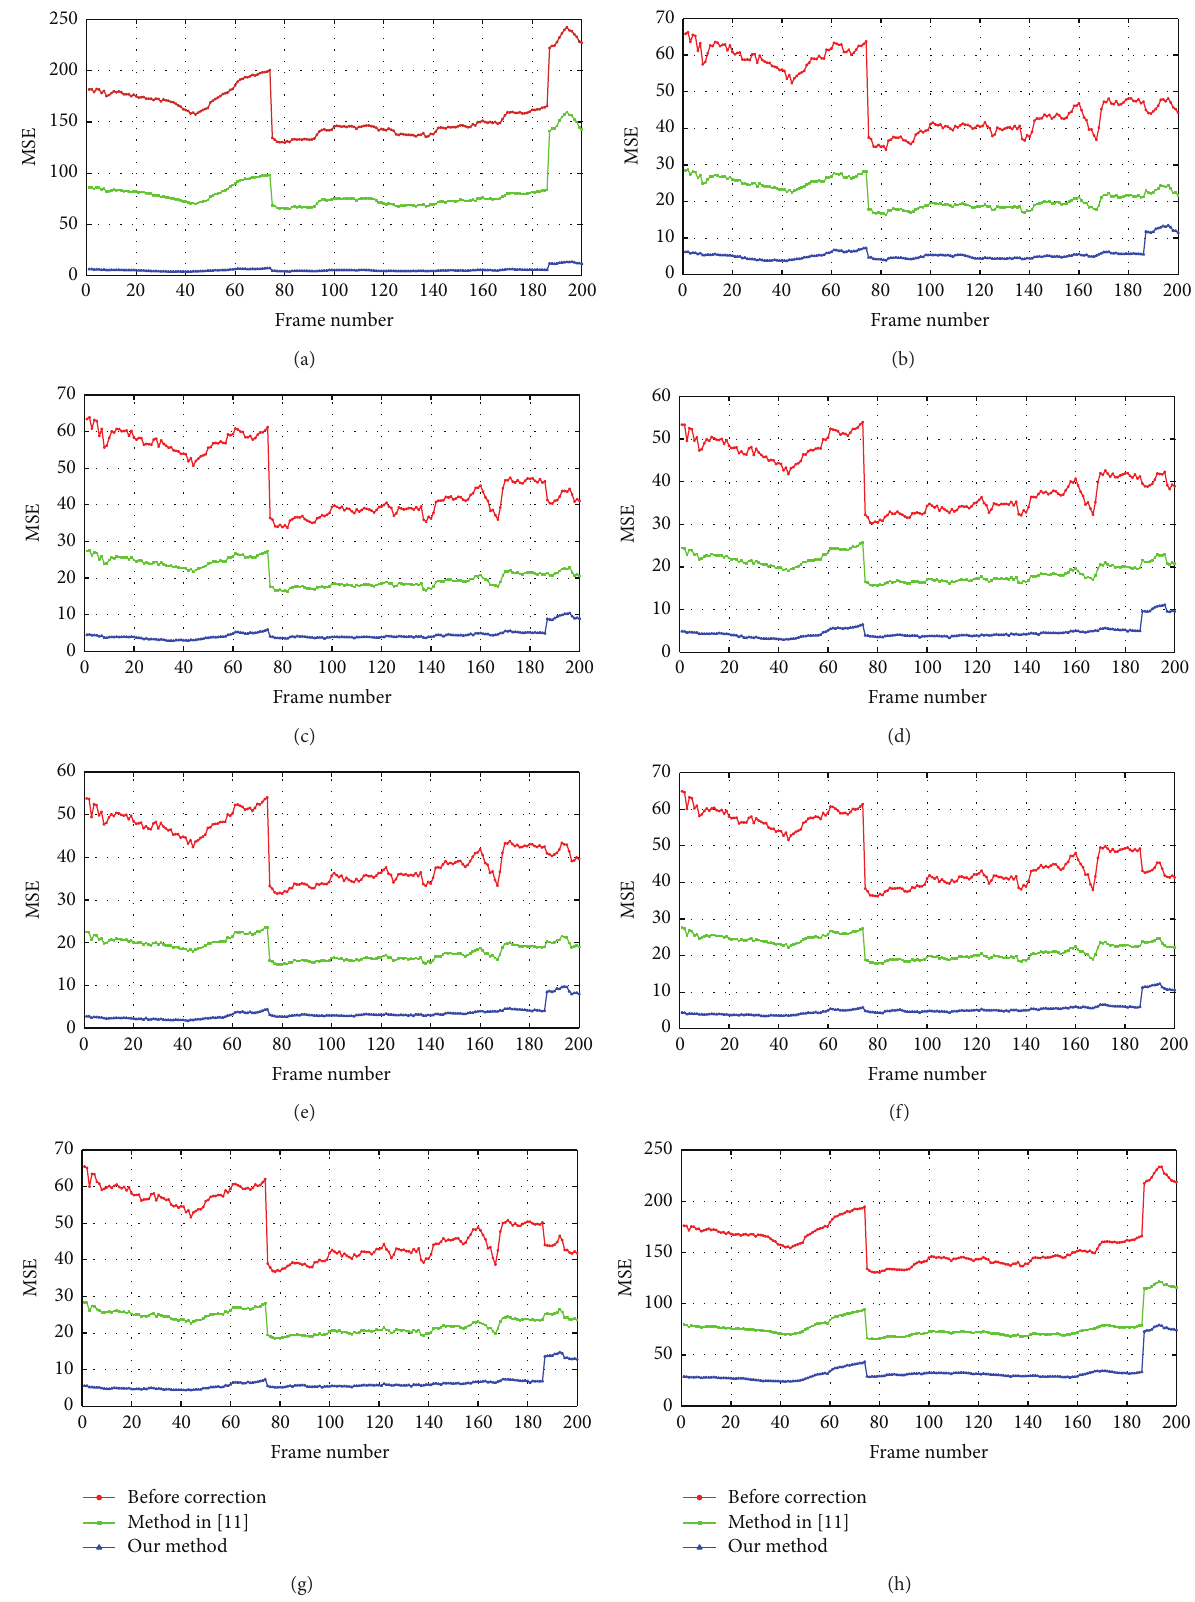
Figure 7: MSE versus frames for each view in “Fireman.” (a) MSE of view 1 in “Fireman.” (b) MSE of view 2 in “Fireman.” (c) MSE of view 3 in “Fireman.” (d) MSE of view 4 in “Fireman.” (e) MSE of view 5 in “Fireman.” (f) MSE of view 6 in “Fireman.” (g) MSE of view 7 in “Fireman.” (h) MSE of view 8 in